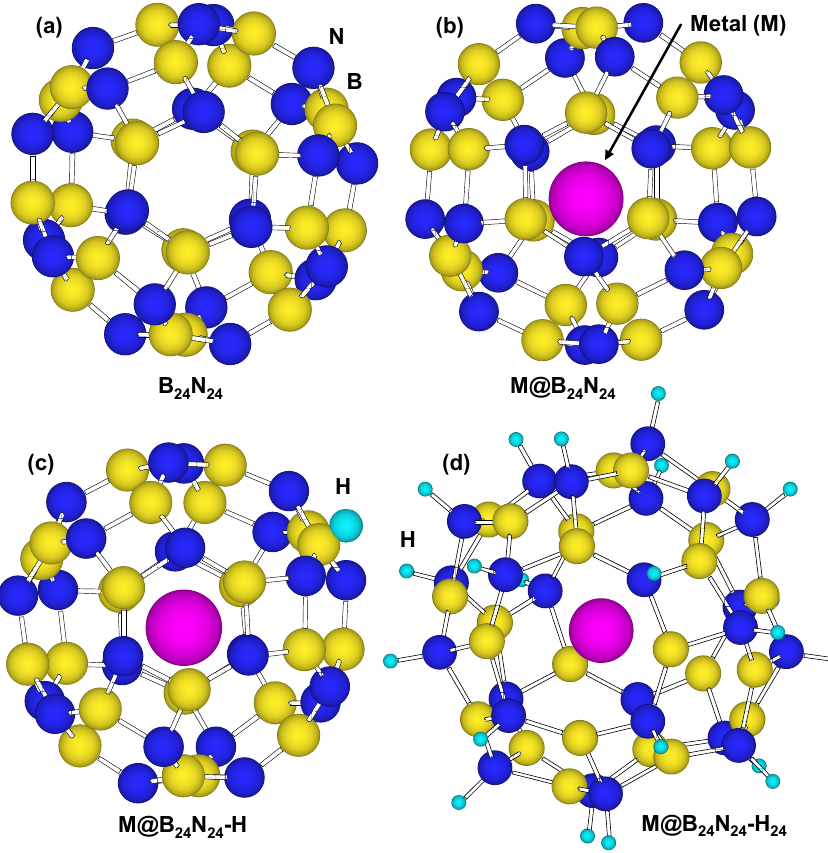
Figure 8. Structural models for ( a ) B 24 N 24 ; ( b ) endohedral M@B 24 N 24 ; ( c ) hydrogenated